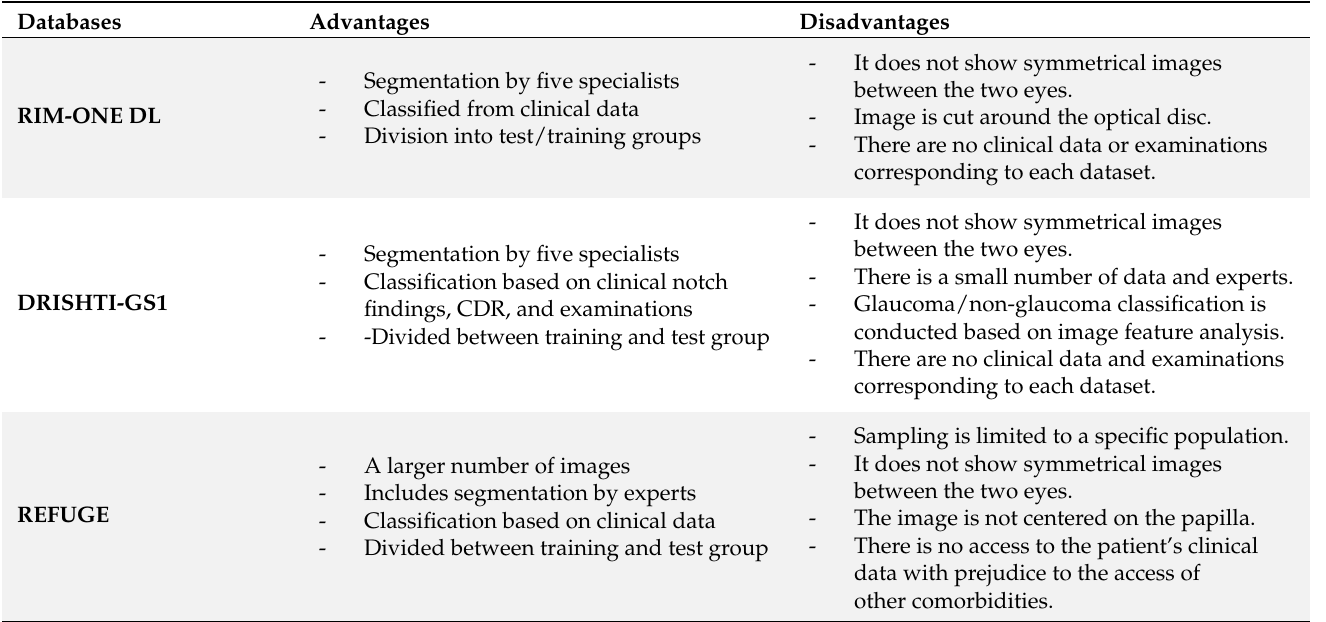
Table 12. Main advantages and disadvantages of gold standard